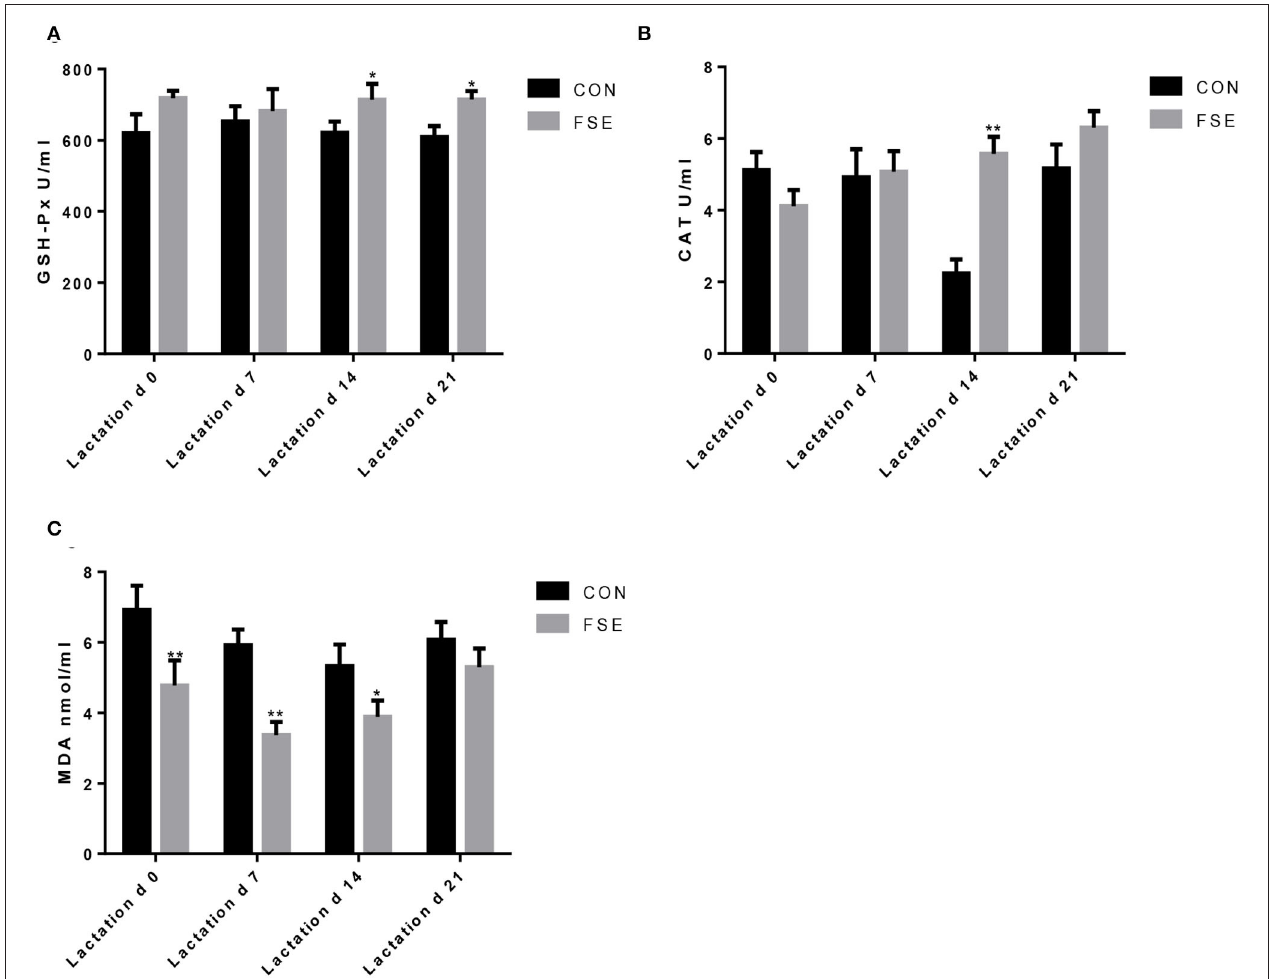
FIGURE 3 | Effects of Forsythia suspensa extract on antioxidant capacity of suckling piglets. CON, control treatment; FSE, Forsythia suspensa extract treatment. (A) GSH-Px, glutathione peroxidase; (B) CAT, catalase; (C) MDA, malondialdehyde. All values are expressed as means ± SEM ( n = 12). * P < 0.05, ** P <